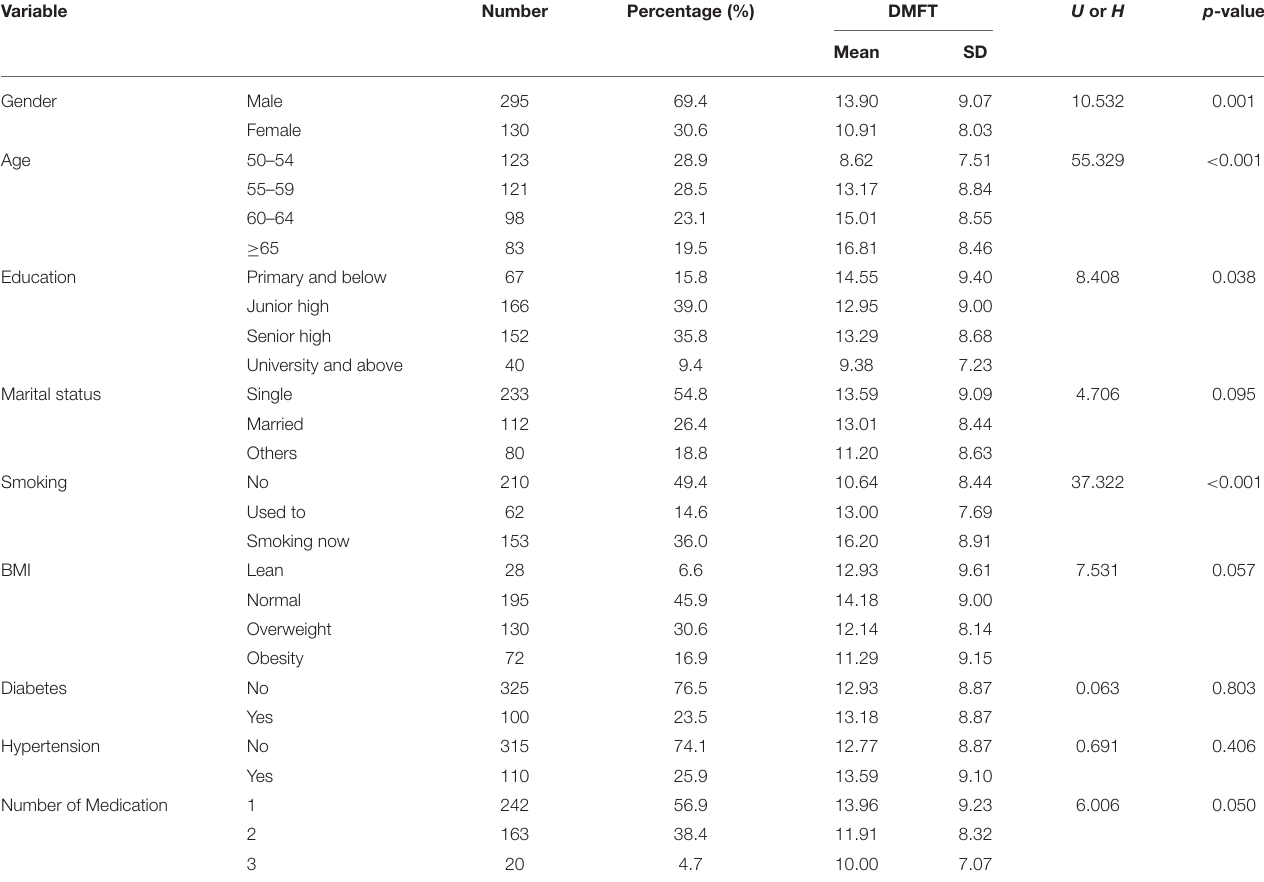
TABLE 2 | DMFT scores of elderly schizophrenia inpatients according to demographic.